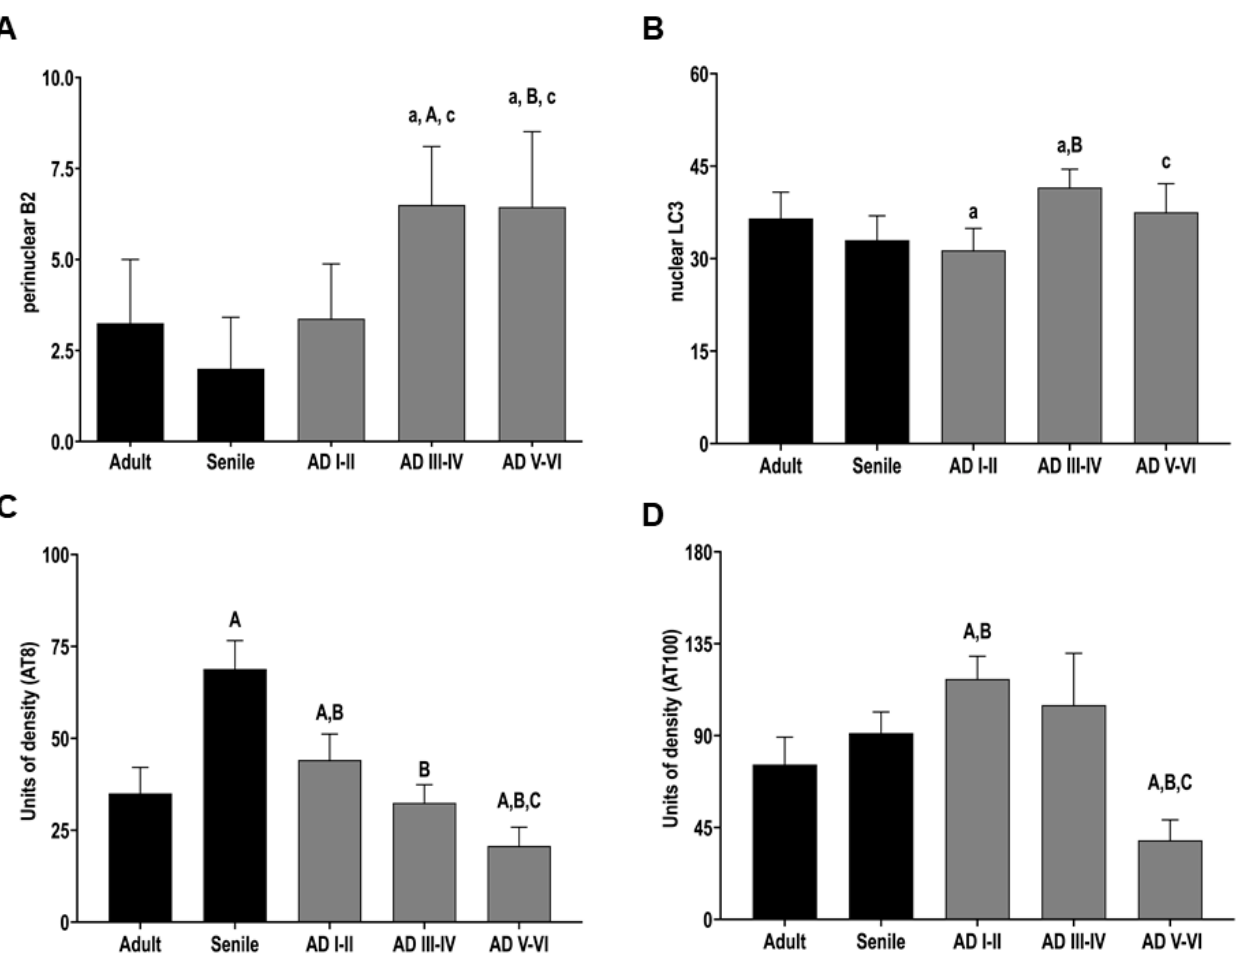
Figure 6. Quantification of AD hallmarks in DG cells. Perinuclear Lamin B2 ( A ) and nuclear LC3 immunopositivity ( B ) show significant increases in intermediate and late AD stages. These changes concur with decreased AT8 nuclear levels ( C ) and AT100 ( D ). Statistically significant differences versus adult (A, p < 0.001, a, p < 0.05), senile subjects (B, p < 0.001), and AD I-II (C, p < 0.001, c, p < 0.05). Each bar represents the mean + SD.